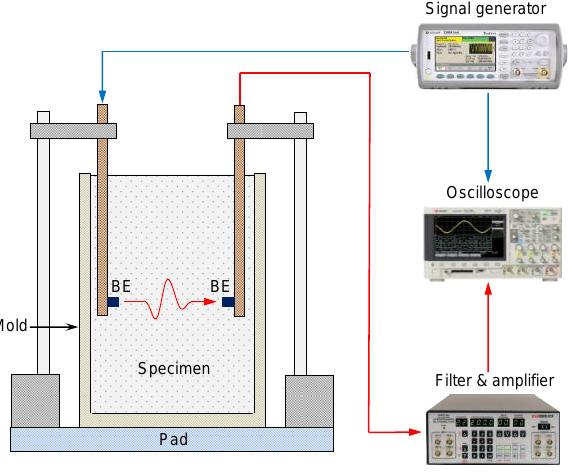
Figure 6. Schematic drawing of test setup for the shear wave measurement. The output signals obtained at two CLSM mixtures along the curing time from 6 h to 28 days are plotted in Figure 7. To investigate the change in the shear wave, the output signals were normalized with their maximum amplitudes at each curing time. For M3, the shear wave was significant on the output signals, even at an early curing time,